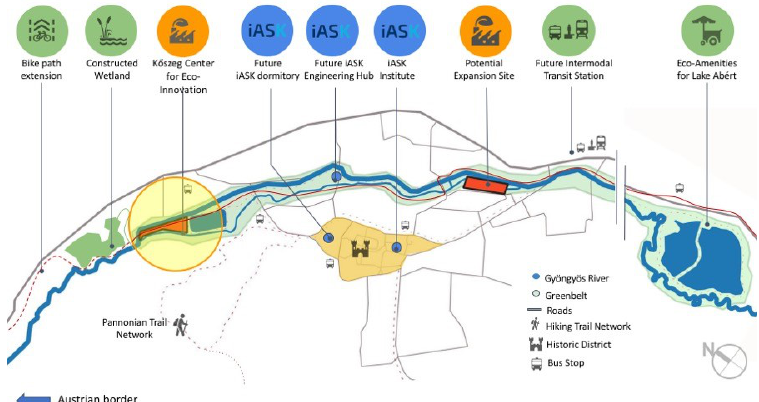
Figure 10. Conceptual Master Plan Showing Education, Innovation and Infrastructural